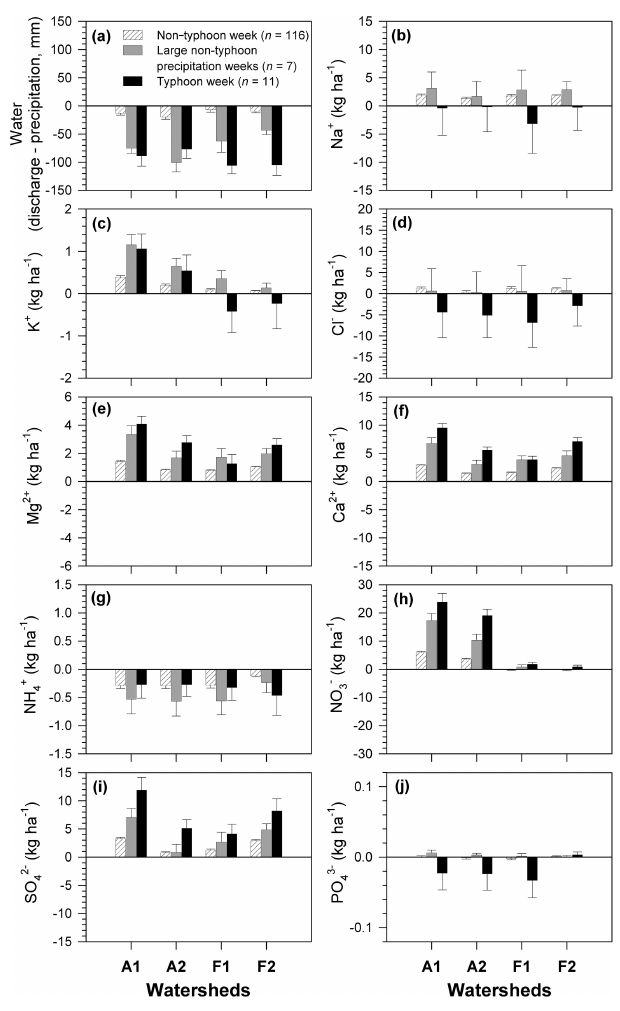
Figure 7. Mean weekly budget for non-typhoon weeks, large non- typhoon precipitation weeks and typhoon weeks. (a) Water quan- tity (stream discharge − precipitation), (b) Na + , (c) K + , (d) Cl − , (e) Mg 2 + , (f) Ca 2 + , (g) NH +